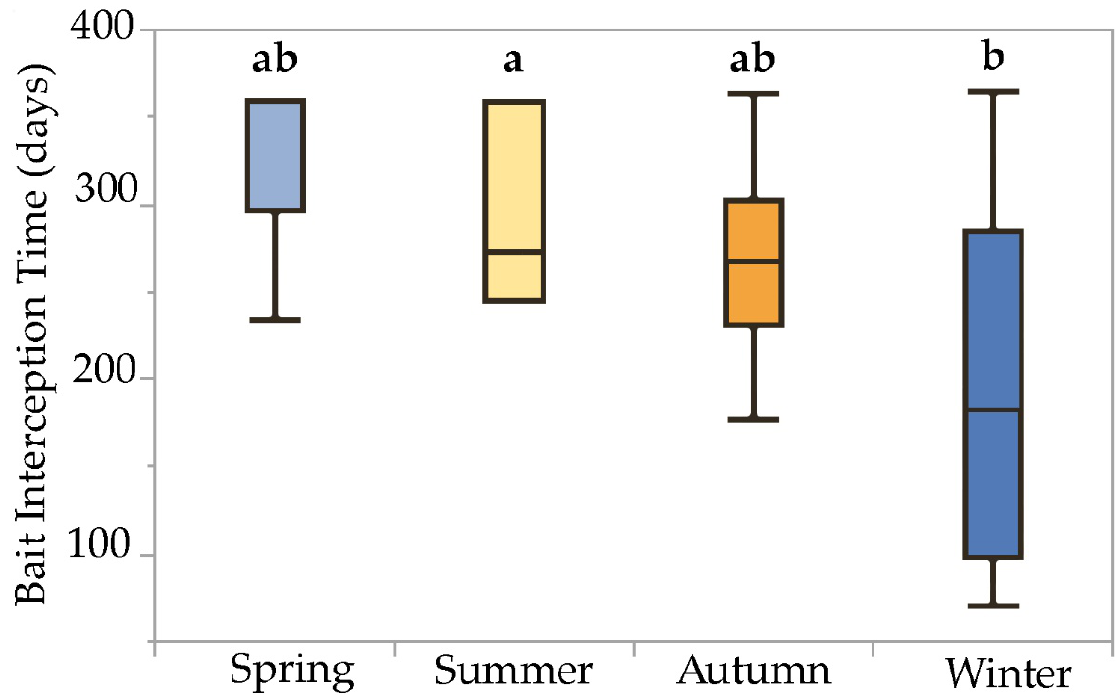
Figure 4. Boxplots illustrating statistical moments associated with bait interception time data collected over a one-year period from termite baits installed during four different seasons in the San Francisco Bay Area. Boxplots with the same letter code are not significantly different (Tukey HSD test on least-squares means, α = 0.05). Interception times for baits installed during winter were significantly less than those for baits installed during summer, while interception times for baits installed during spring and autumn were statistically intermediate between winter and summer.